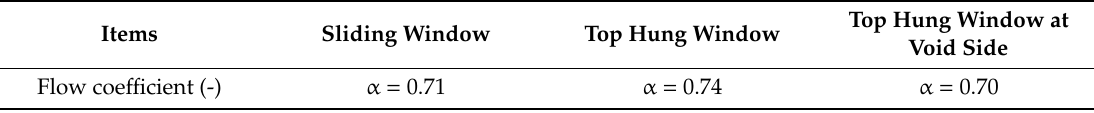
Table 5. Analysis case for natural ventilation rate network simulation.